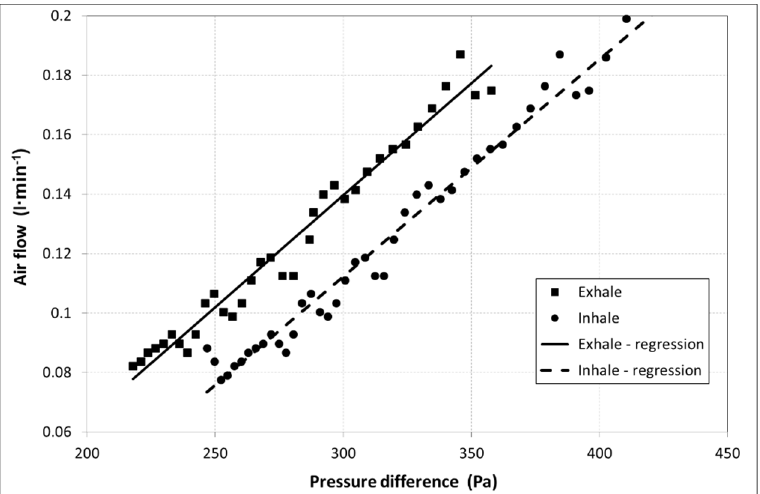
Figure 11. A correlation between the flow rate of the air leaking through the skin–facepiece interface and